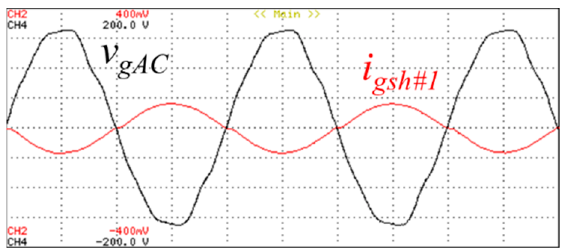
Figure 10. Experimental results showing the voltage ( v gAC ) (100 V/div) and the current (5 A/div) of the AC grid of smart home #1 ( i ACsh# 1 ) on the main AC grid when the front-end AC/DC converter is injecting energy into the power grid.